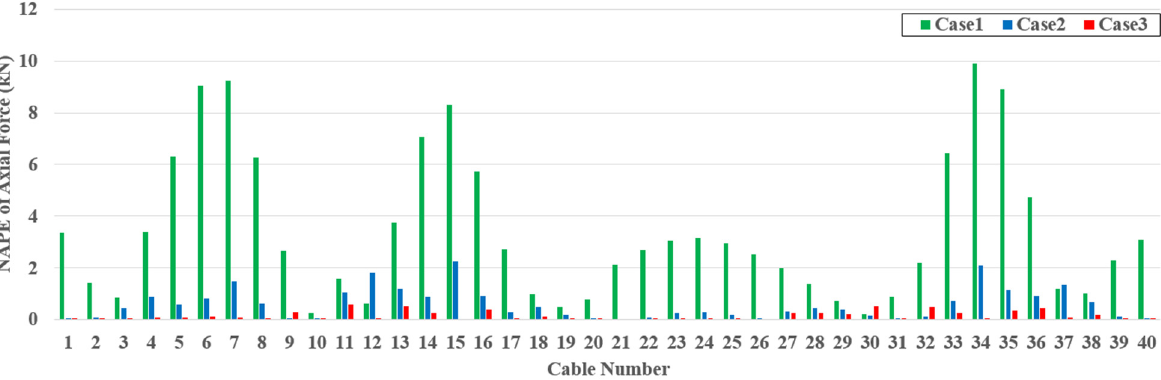
Figure 14. NAPE of estimated cable axial force for TM4.